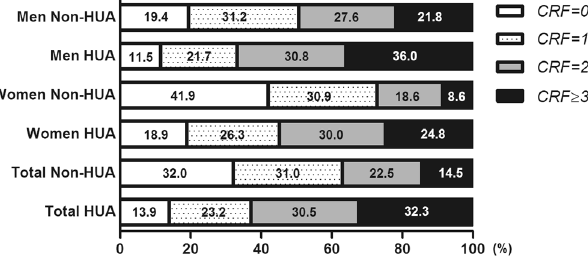
Figure 1. Prevalence of CRFs clustering among normouricemic and hyperuricemic adults. HUA, hyperuricemia; CRFs, cardiovascular risk factors, including dyslipidemia, hypertension, diabetes, current smoking, and